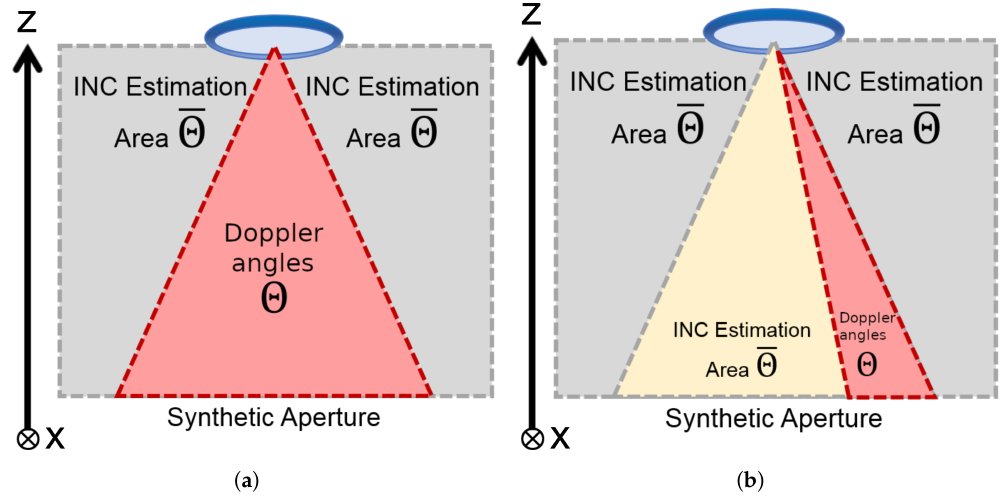
Figure 11. ( a ) At each time instance, the radar is receiving returns from the entire synthetic aperture. ( b ) In the range-Doppler domain, the AoA in azimuth is correlated with the Doppler frequency. This can be utilized to reduce the blindspot because the instantaneous Doppler angle is different in each Doppler